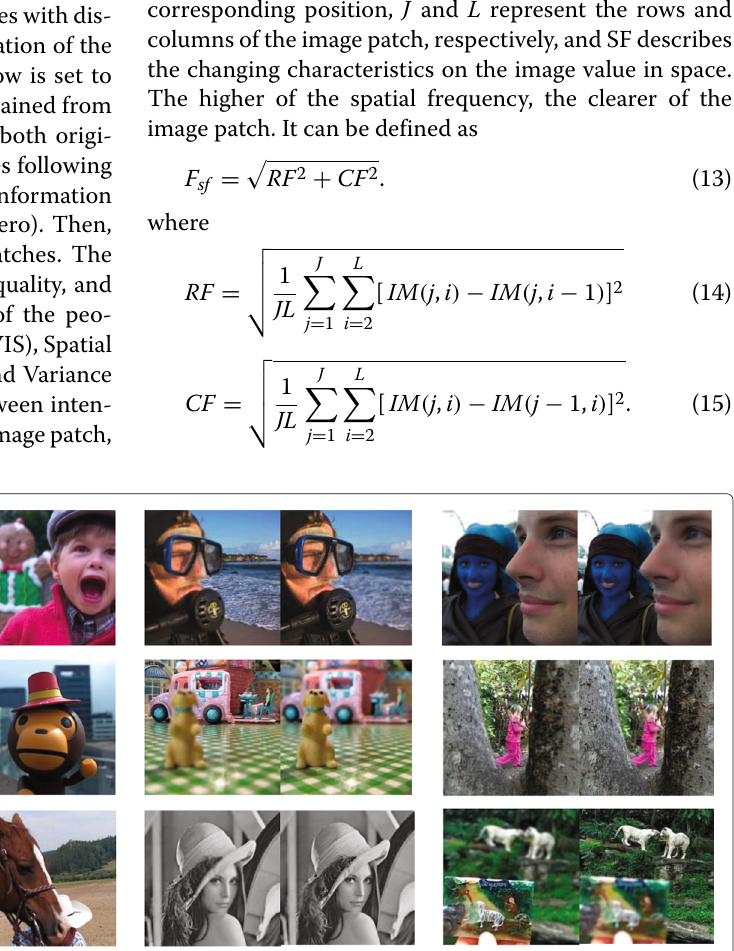
Fig. 5 A part of test images of the proposed method. We show some test images that are taken from different